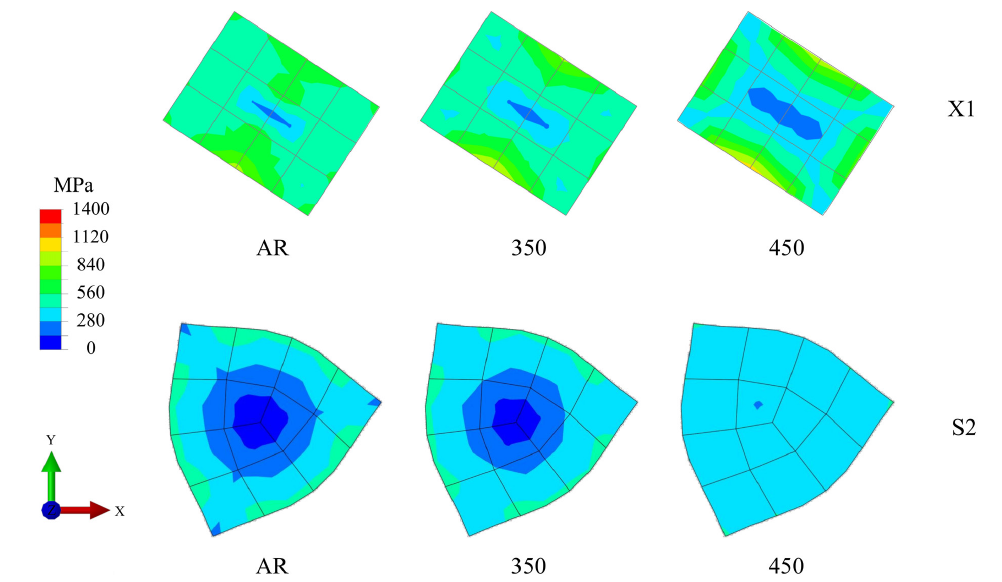
Figure 9. The von Mises stress distribution in the cross-section at 3 mm from the tip under torsion at 0.10 Ncm clockwise.